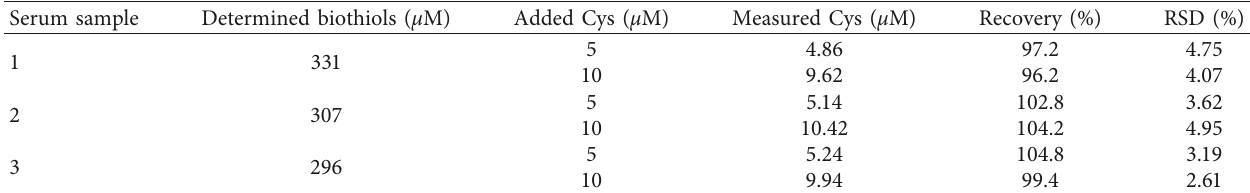
Table 1: Determination of Cys in human serum samples using the proposed method. Serum sample